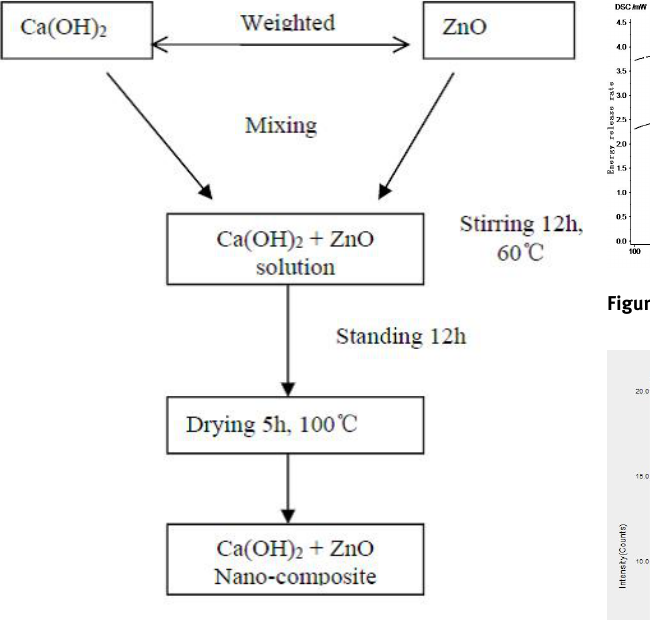
Figure 1: The preparation process of Ca 2− α Zn α (OH) 4 .